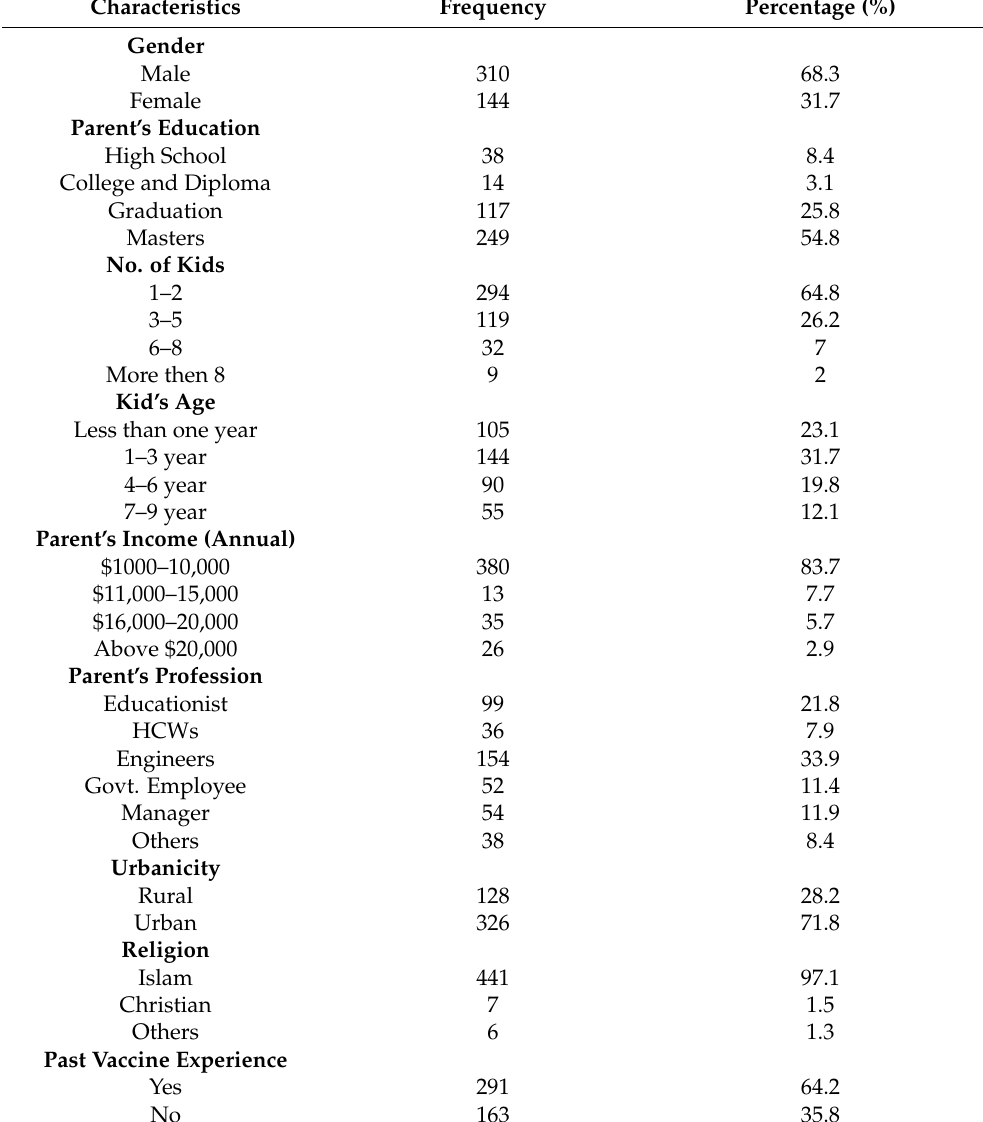
Table 1. Descriptive statistics.